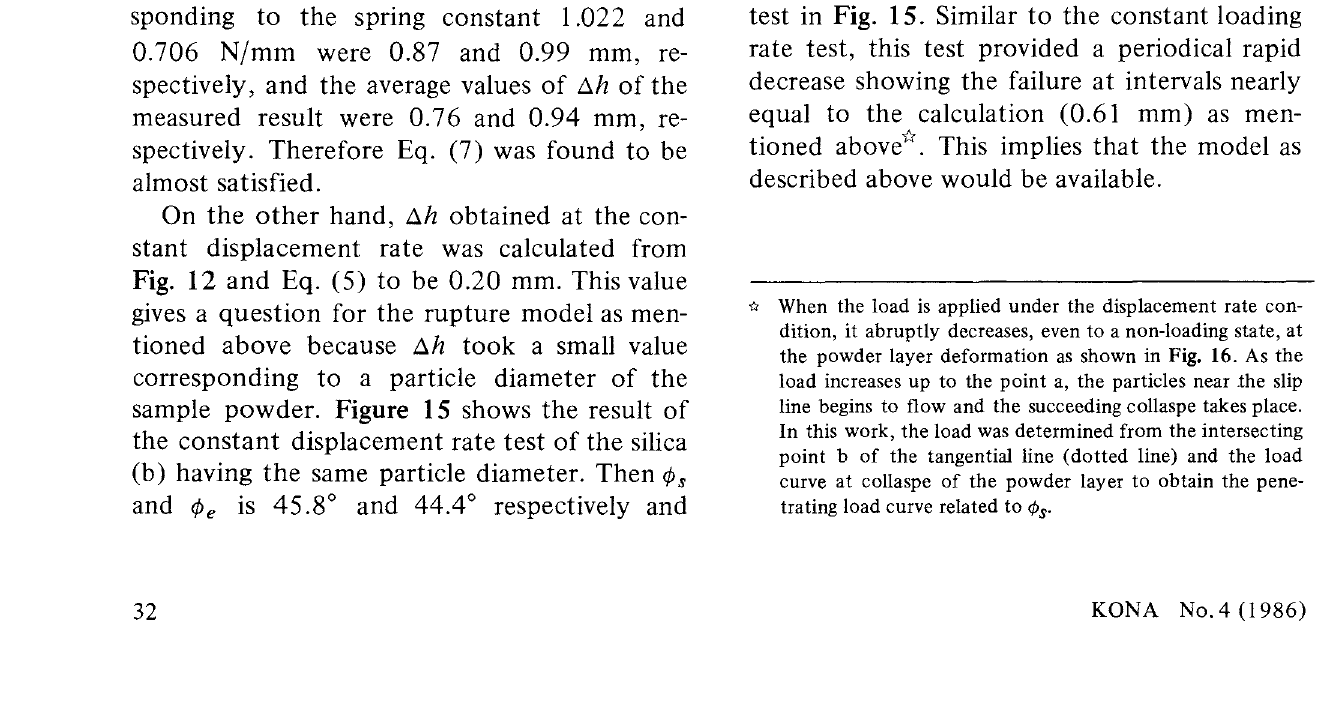
Fig. 16 Representative waveform of the load required to penetrate a circular plate into powder bed 0.61 mm was calculated from Eq. (5). This means that t::.h would depend on ¢s and ¢e, independently of the particle diameter. Figure 16 shows a part of the waveform which is in dicative of the fluctuation of the load for the test in Fig. 15. Similar to the constant loading rate test, this test provided a periodical rapid decrease showing the failure at intervals nearly equal to the calculation (0.61 mm) as